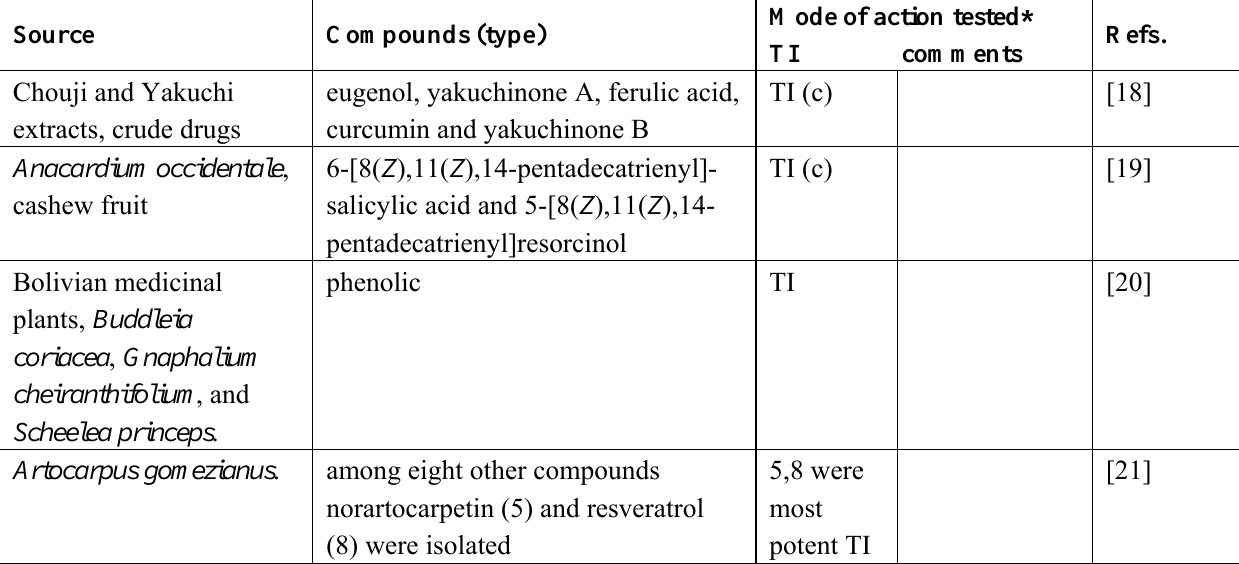
Table 1. Compounds selected as tyrosinase inhibitors by extraction from natural sources and the (possible) isolation and characterization of the active